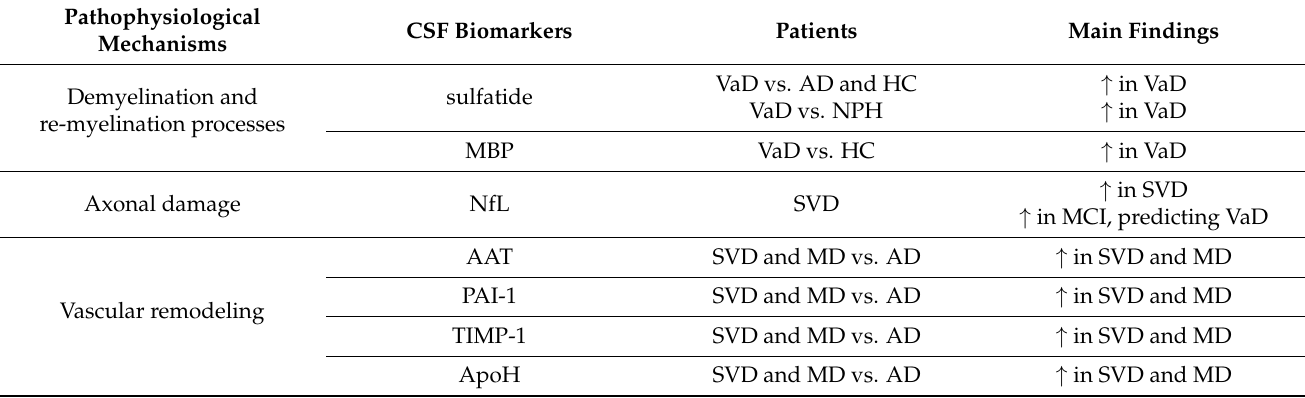
Table 1. The table shows the main findings on cerebrospinal fluid biomarkers to investigate small vessel disease within neurological diseases. Legend. AAT: α -1 antitrypsin; AD: Alzheimer’s disease; ApoH: apolipoprotein H; CSF: cere- brospinal fluid; HC: healthy controls; MBP: myelin basic protein; MCI: mild cognitive impairment; MD: mixed dementia (AD + SVD); NfL: neurofilament light chain; NPH: normal pressure hydrocephalus; PAI-1: plasminogen activator inhibitor 1; SVD: small vessel disease; TIMP-1: tissue inhibitor of metalloproteinase 1; VaD: vascular dementia; WML: white matter lesions, ↑ :